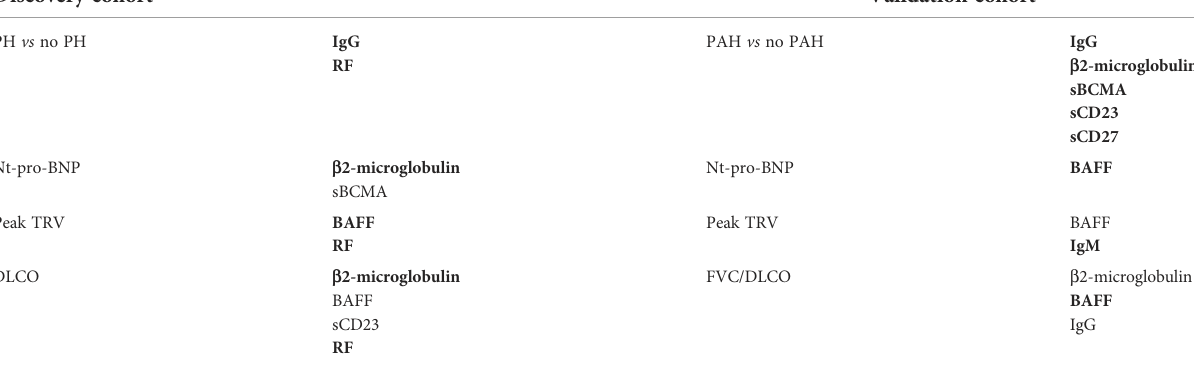
TABLE 8 Synthetic view of the associations identi fi ed between soluble markers of B cell activation and clinical markers of PH in the discovery and validation cohorts. Discovery